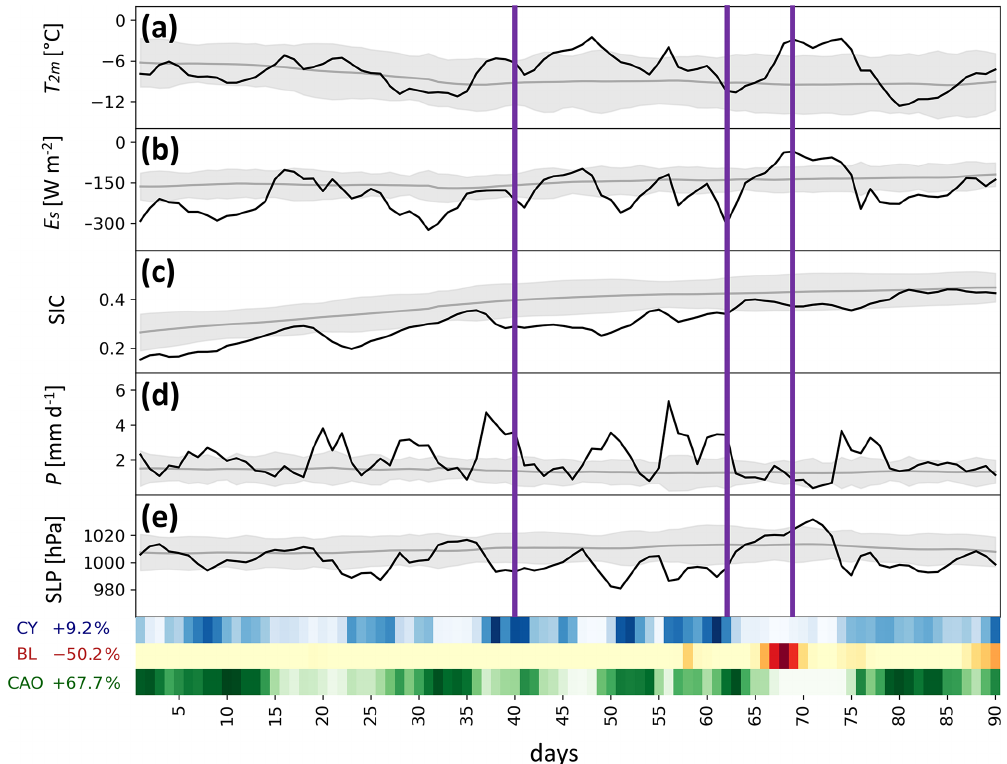
Figure 10. Same as Fig. 9 but for DJF 2016/17. Purple vertical lines indicate the three time steps shown in Fig. 11: 9 January 2017 (day 40), 31 January 2017 (day 62) and 7 February 2017 (day 69).